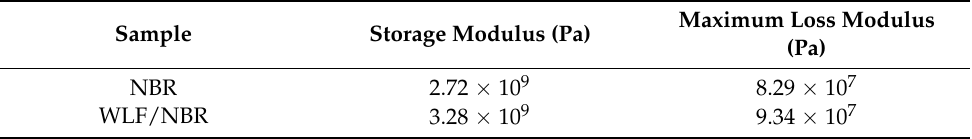
Table 3. Storage modulus (E (cid:48) ) and maximum loss modulus (E” max ) of NBR and WLF/NBR composite with the ratio of 50/50 wt%